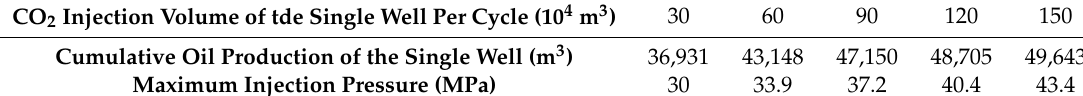
Table 9. Calculation results of di ff erent injection volumes.